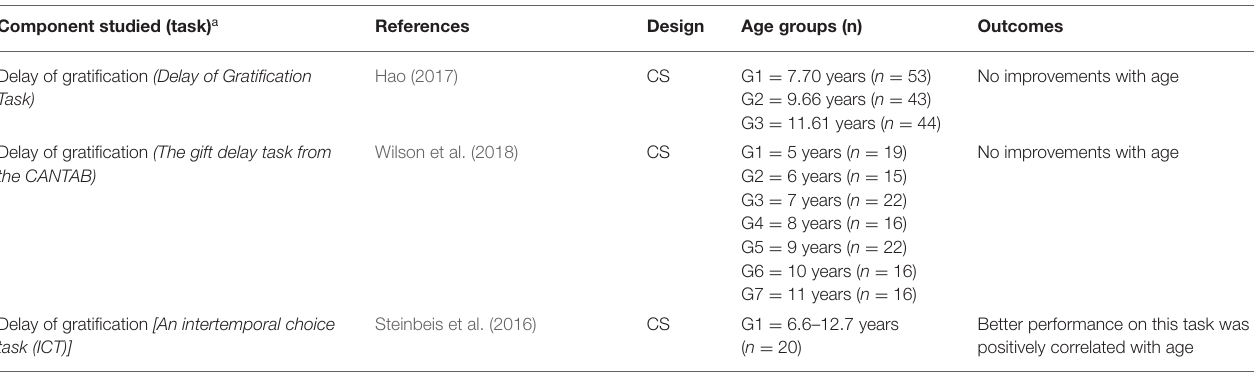
TABLE 5 | Studies on the development of the delay of gratification ( n =